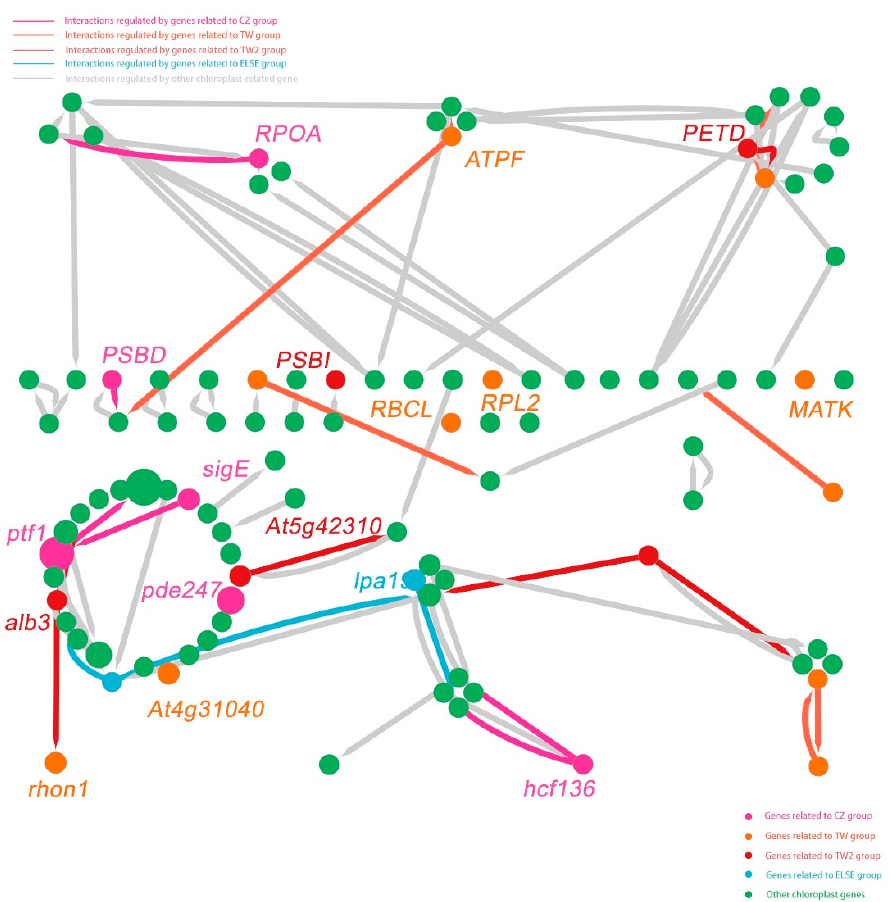
Figure 9. Gene regulatory network for A. thaliana chloroplast-related gene regulation. Nodes repre- sent the genes related to different groups. Line color represents interactions regulated by genes in the different groups. Genes in uppercase letters represent location-related, polymorphic, homologous C. argyrophylla chloroplast genes, and genes in lowercase letters represent the literature-re- ported related chloroplast genes of those in uppercase letters.